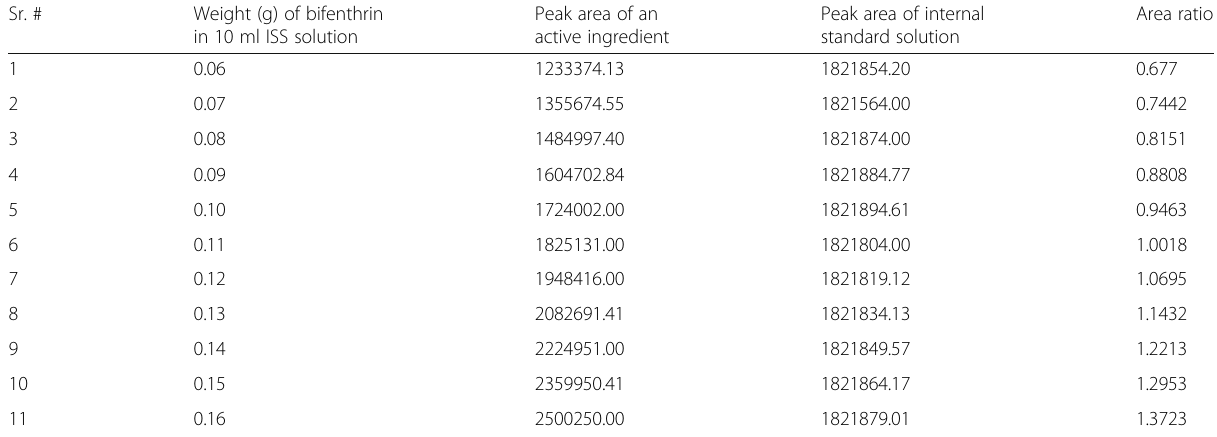
Table 2 Bifenthrin responses summarized according to the increased concentration (linearity) Sr. #